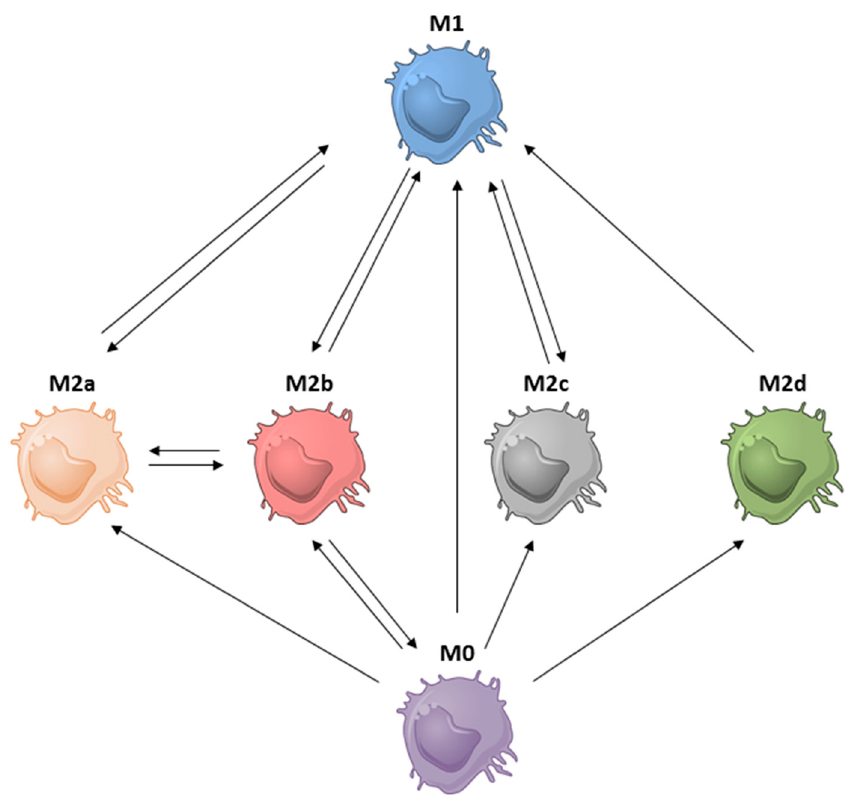
Figure 6. Relationship between the different macrophage subsets. For details see the text.